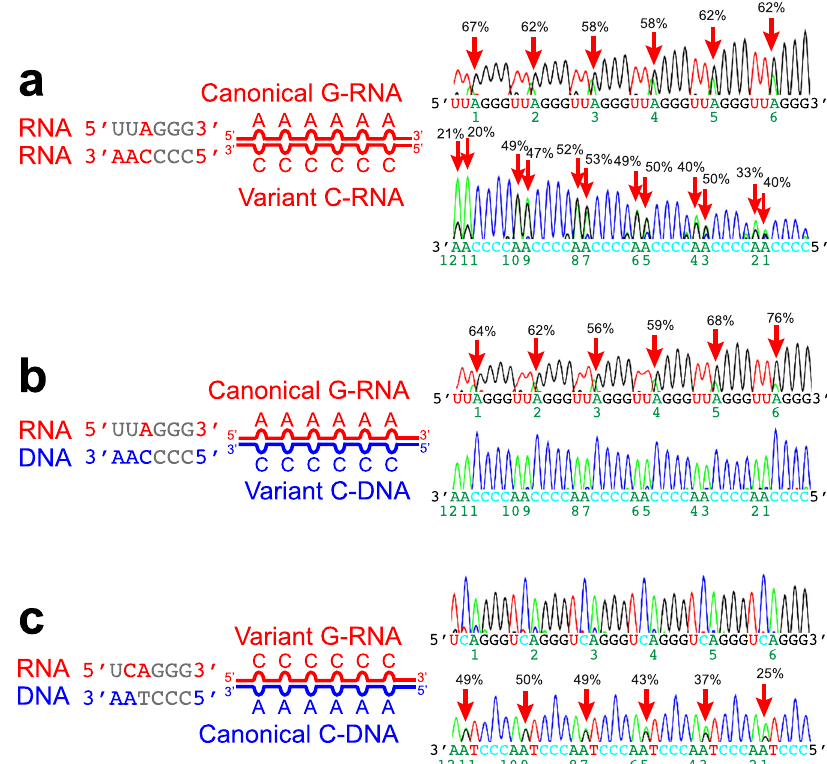
Fig. 7 ADAR1p110 edits both RNA and DNA strands of telomeric repeat RNA:DNA hybrids containing A – C mismatches. a – c In vitro editing assay for telomeric repeat dsRNA ( a ) and RNA:DNA hybrids ( b , c ) containing A – C or C – A mismatches was conducted using ADAR1p110-WT recombinant protein. PCR products (RT-PCR-ampli fi ed RNA strands and PCR-ampli fi ed DNA strands) were subjected to Sanger sequencing. Editing frequency estimated for three independent experiments ( n = 3, technical replicates) is presented in Supplemental information (Supplementary Data 2 and Source Data fi